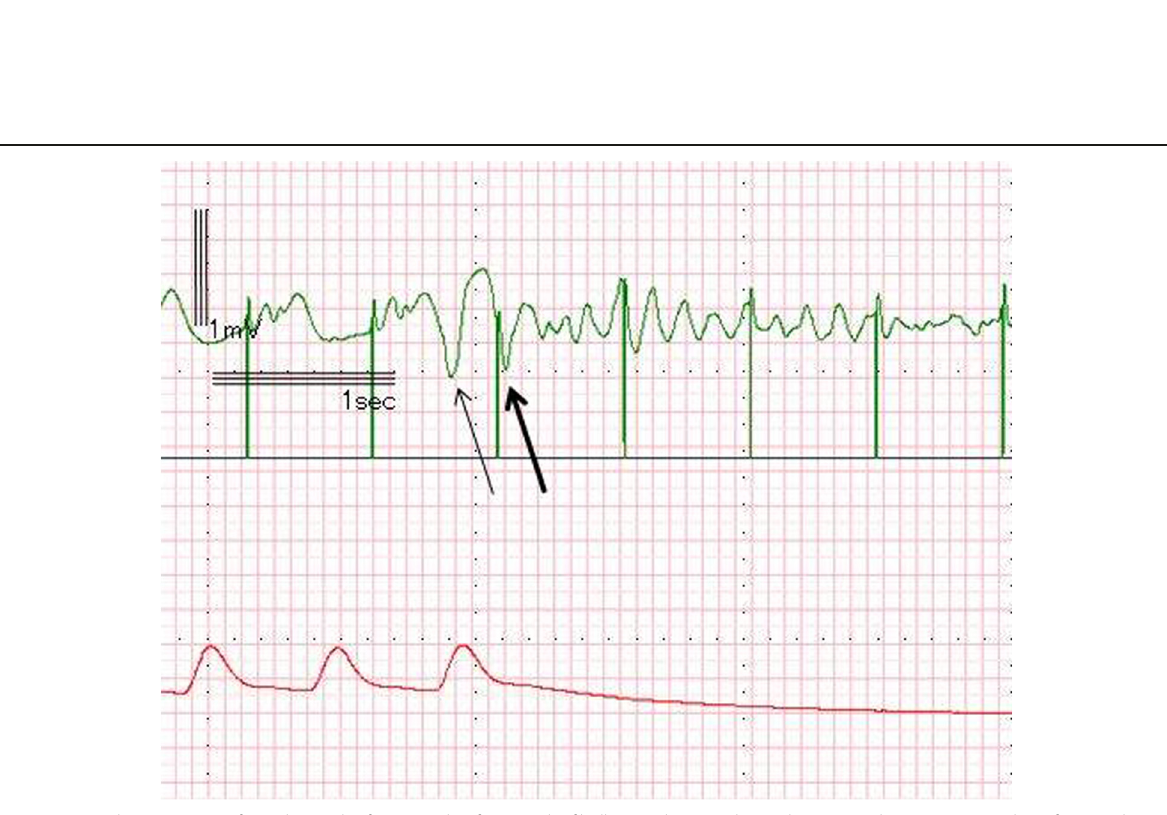
Fig. 3 ECG and pressure waveform during the first episode of ventricular fibrillation. This ECG shows the R-on-T phenomenon resulting from undersen- sing of a PVC. A pacing spike hit the T wave (large arrow) following a PVC (small